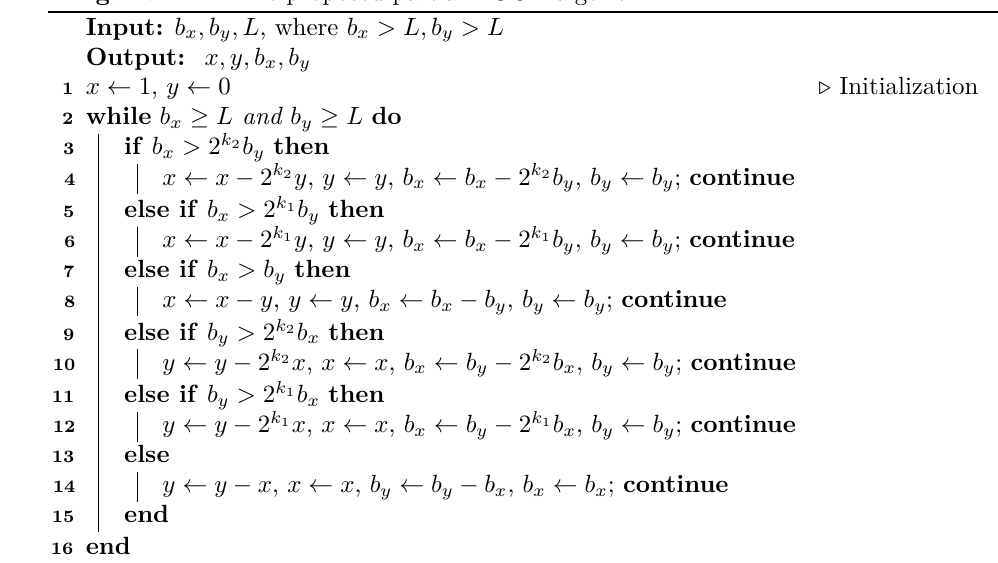
Algorithm 4: The proposed partial XGCD